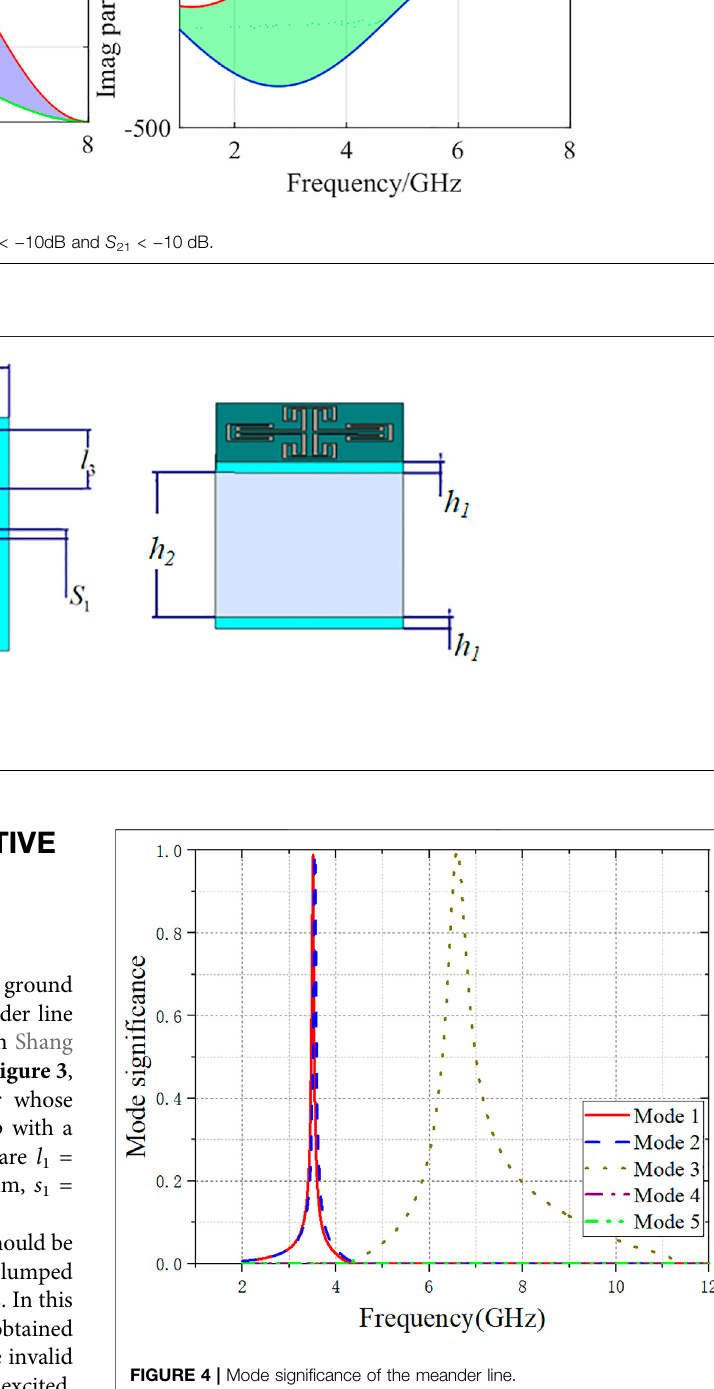
FIGURE 4 | Mode signi fi cance of the meander